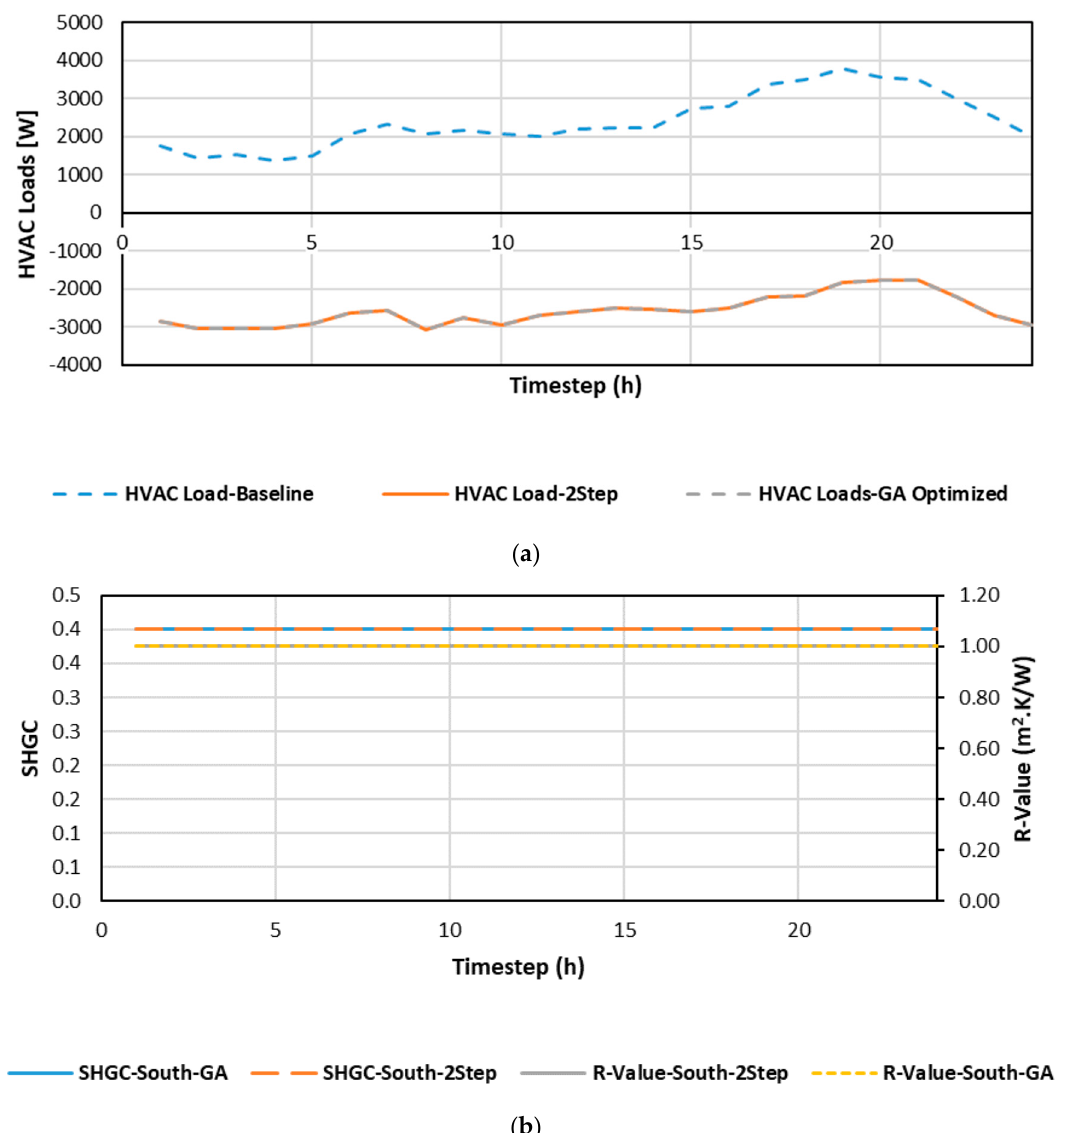
Figure 9. Hourly variations of ( a ) R-values and SHGC settings, and ( b ) thermal loads for an STIS–smart window with a southern exposure during a winter day (18 December) for a dwelling located in Golden, CO, USA.